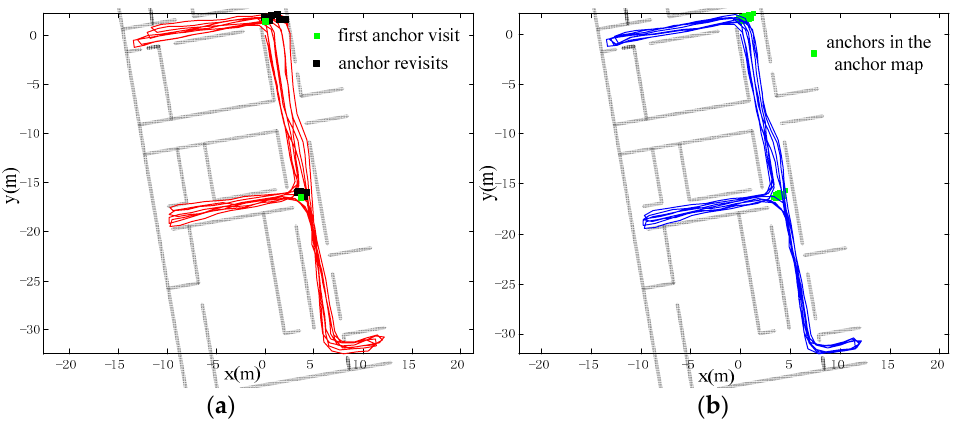
Figure 12. Test one: Office building scenario with abundant anchor revisits ( a ) Raw trajectory with multiple iterations; ( b ) calibrated trajectory with better consistency than raw trajectory.